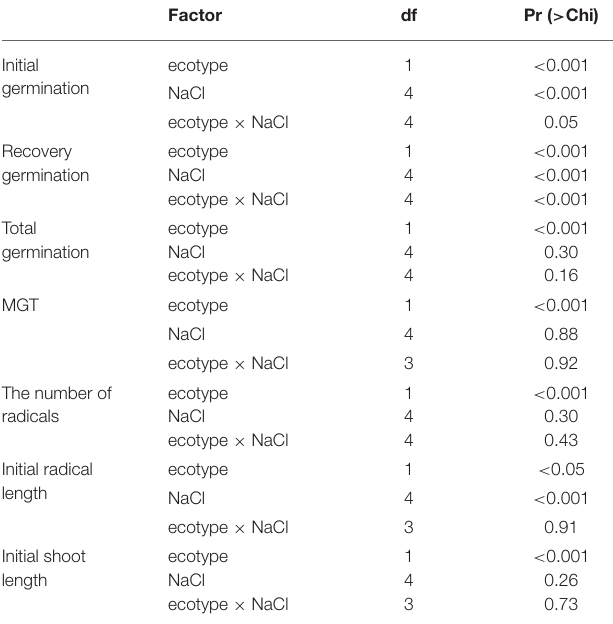
TABLE 2 | Generalized linear models of the effects of ecotypes, salt concentration, and their interactions on the initial and total germination percentage, mean germination time, the number of radicles, and the length of the radicle and shoot during and after salt